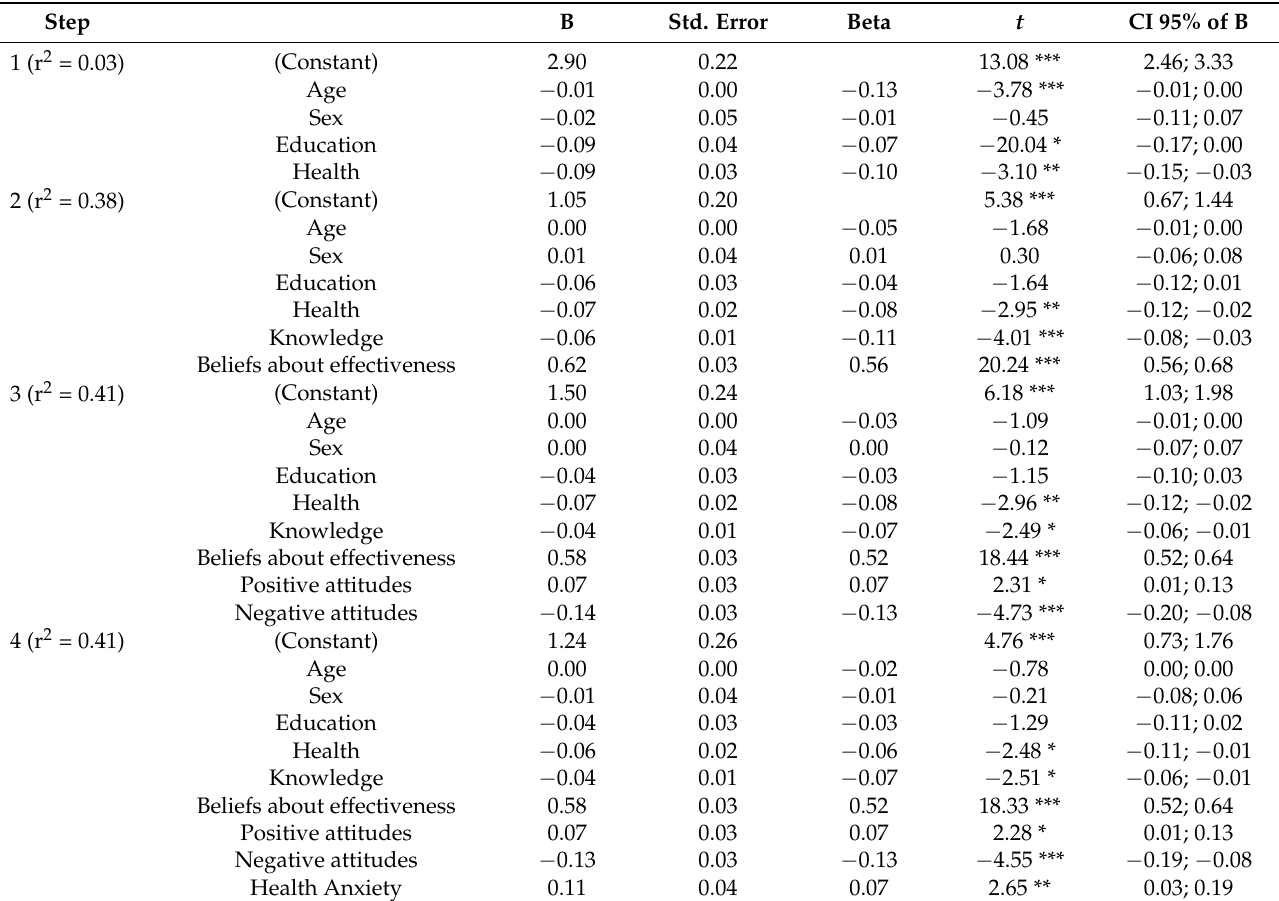
Table 4. Hierarchical regression results for predicting antibiotic